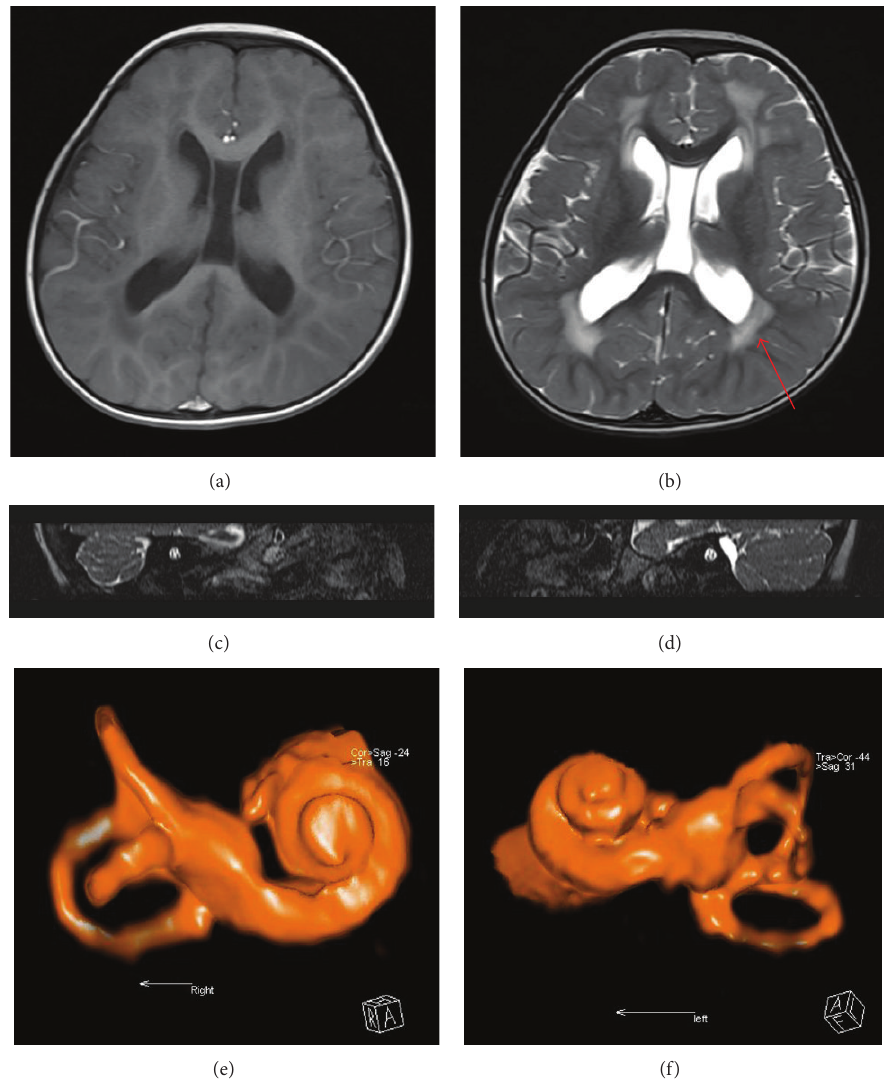
Figure 1: MR imaging of a representative patient with SNHL. (a, b) Axial T1 and T2 weighted imaging showed abnormal signal in the white matterinthebilateralperiventricularareaandenlargementofseptumpellucidum. (c,d)Sagittal3D-SPACEimagingshowedthenormalfacial nerve, cochlear nerve, and vestibular nerves in the internal auditory canal. (e, f) Volume rendering imaging showed the normal structure of the inner ear. IT-MAIS score of this patient improved from 0 to 10 after